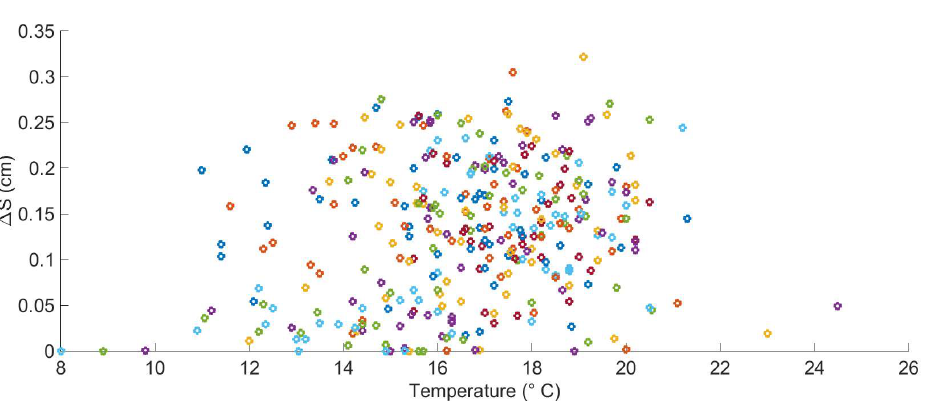
Figure 4. Scatter diagram of the variations of mussel shell length ( ∆ S ) vs. temperature for 10 days periods during the 17 year time series (each color represents a year of the 1996–2012